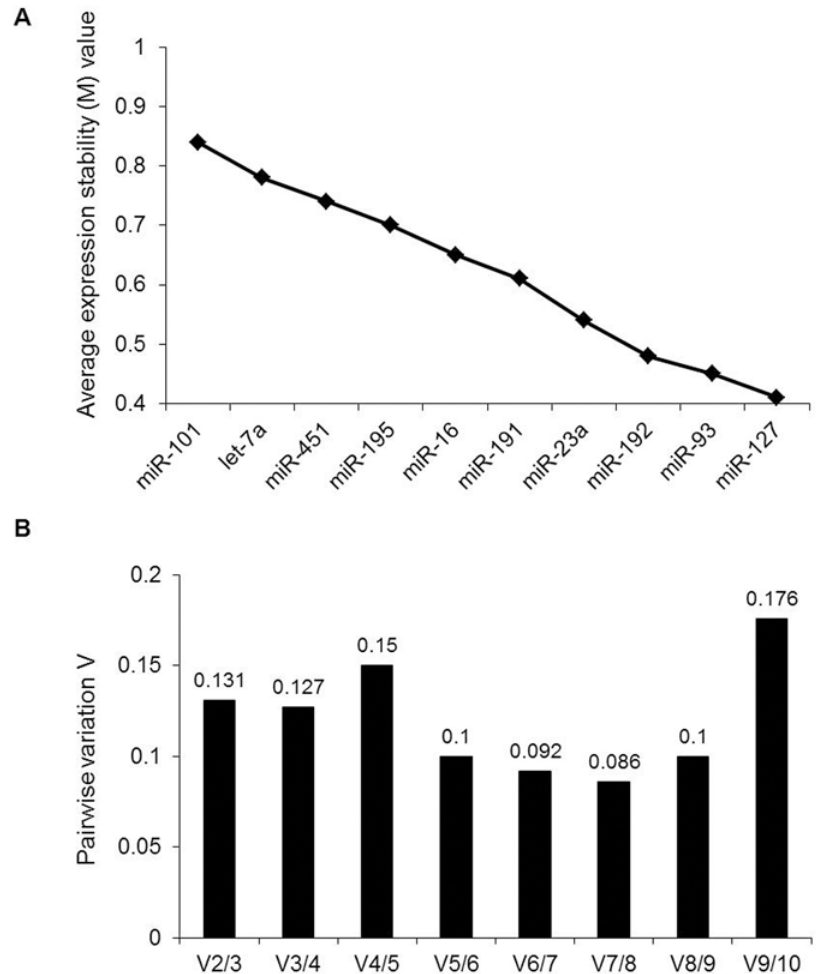
the genes according to their expression stability. (B) Determination of the optimal number of reference genes for normalization. The software calculates the normalization factor from at least two genes; the variable V defines the pairwise variation between two sequential normalization